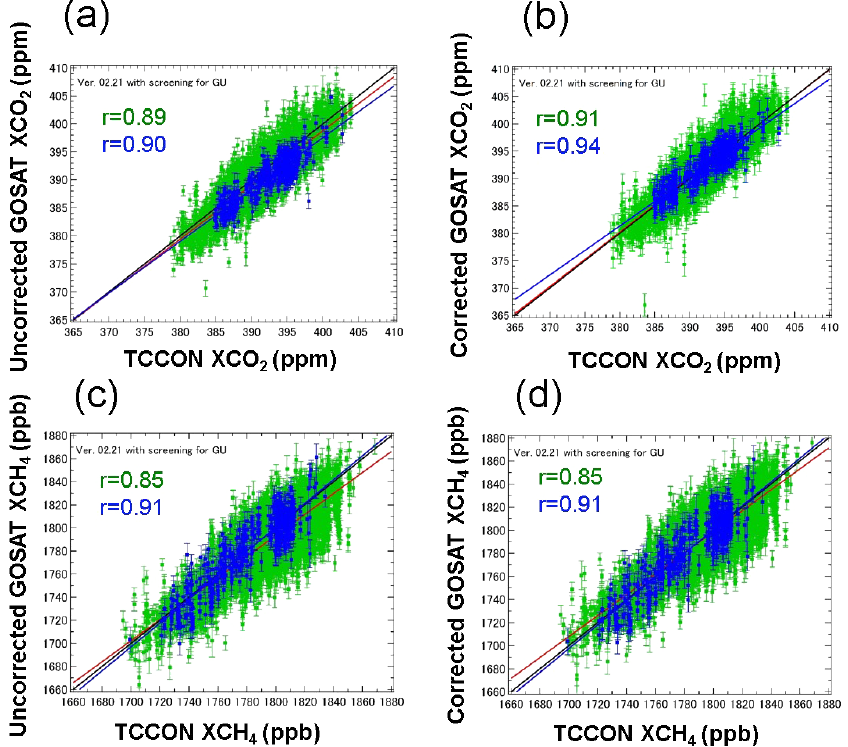
Figure 4. Scatter diagrams between (a) uncorrected and (b) corrected GOSAT XCO 2 observed within ± 5 ◦ latitude/longitude boxes (centered at each TCCON site) and TCCON XCO 2 measured on the same day. (c, d) , same as (a) and (b) for XCH 4 . Green and blue dots indicate GOSAT data obtained over land and ocean regions, respectively. Red and blue lines denote the regression lines, statistically significant at the 99% level, over land and ocean regions, respectively. Black lines show the one-to-one